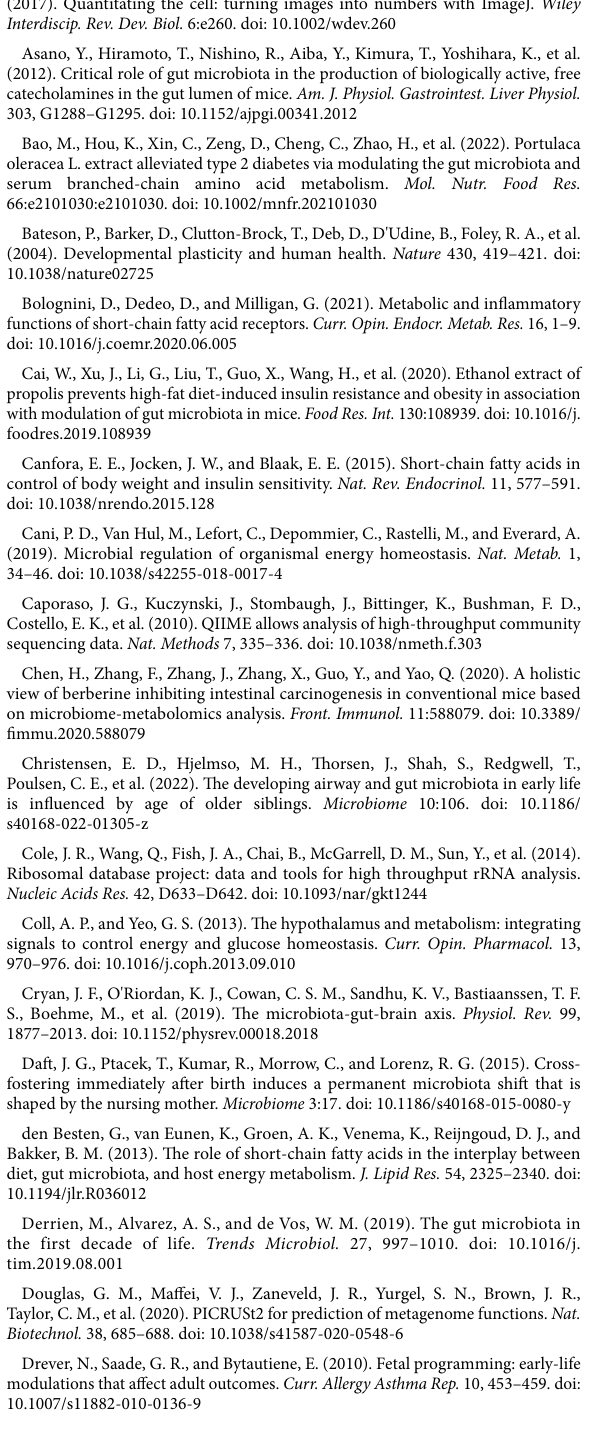
SUPPLEMENTARY FIGURE S1 Vaginal microbiota analysis in pregnant E18.5 HE and NC mice. (A,B) Chao 1 and Shannon indices ( n = 3). (C) Heatmap of top 30 enriched genera. Error bars represent SEM. Significance determined by Student’s t -test. ns, not significant.